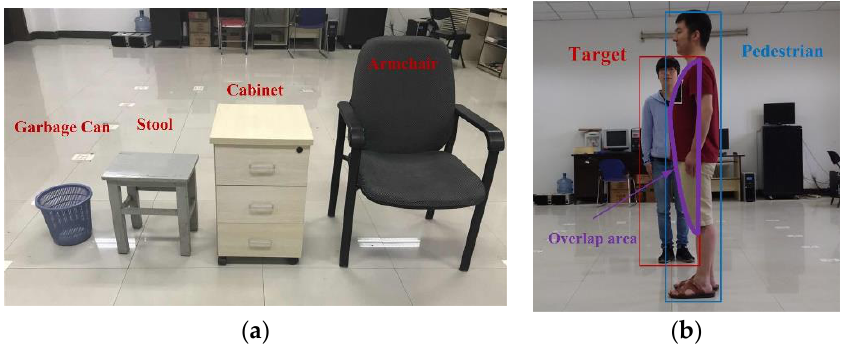
Figure 9. Indoor obstacles environments. ( a ) Stationary obstacles; ( b ) pedestrian blockage.